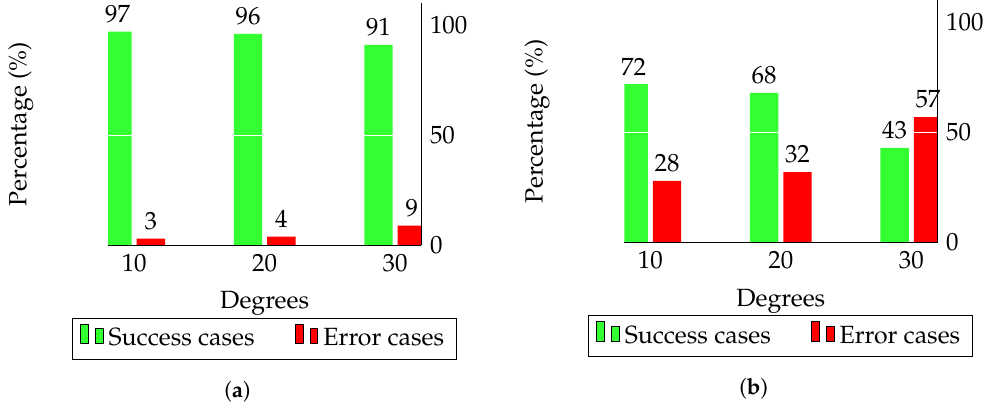
Figure 12. Error rate on a 10 , 20 and 30 degree inclined surface. ( a ) Thick wheel model; ( b ) Bookreader 2